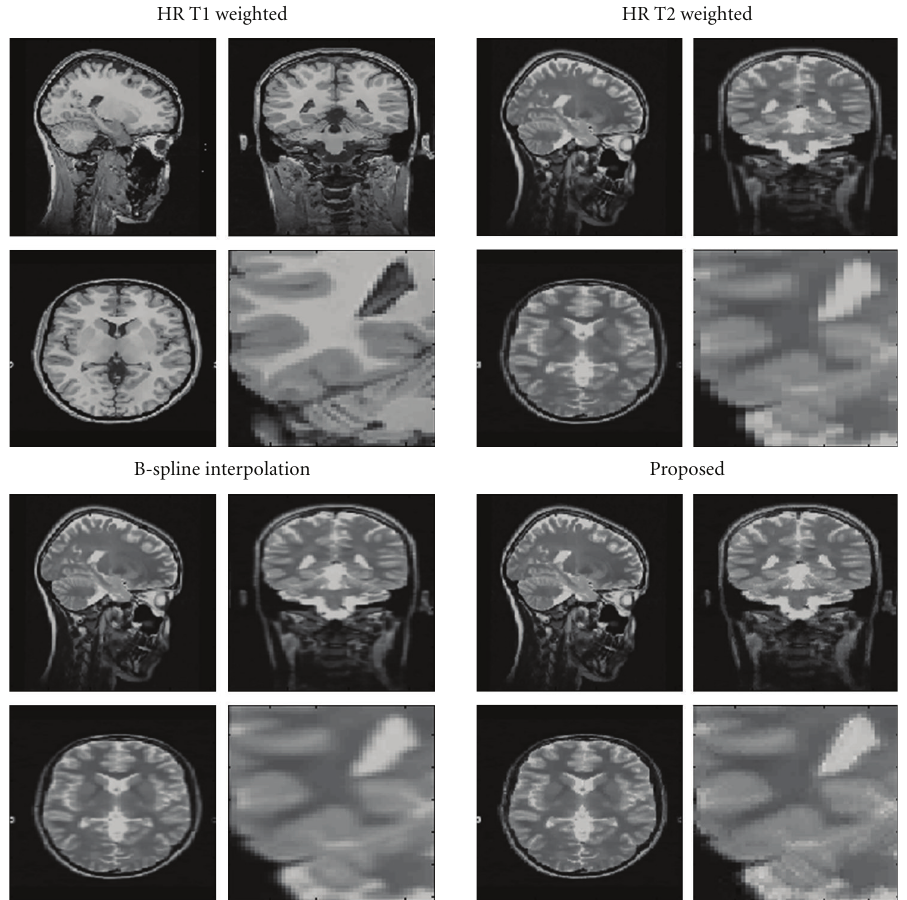
Figure 7: Comparison on real clinical data. Top-Left: HR T1-w volume. Top-Right: LR T2-w volume. Bottom-left: B-Spline reconstruction. Bottom-right: reconstruction using the proposed method. In each case a close-up is presented to better show how the proposed method provides a more consistent and less blurry